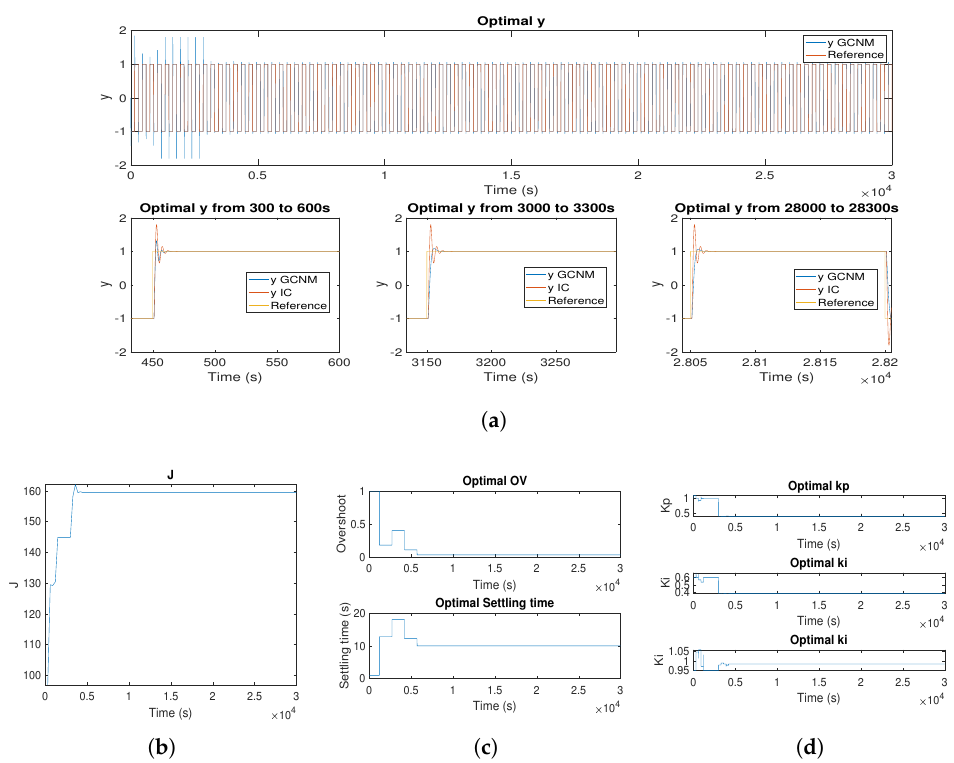
Figure 5. FOSOC controller: ( a ) time response, ( b ) cost function, ( c ) overshoot and settling time, and ( d ) FOPI gains evolution for L = 1 s.